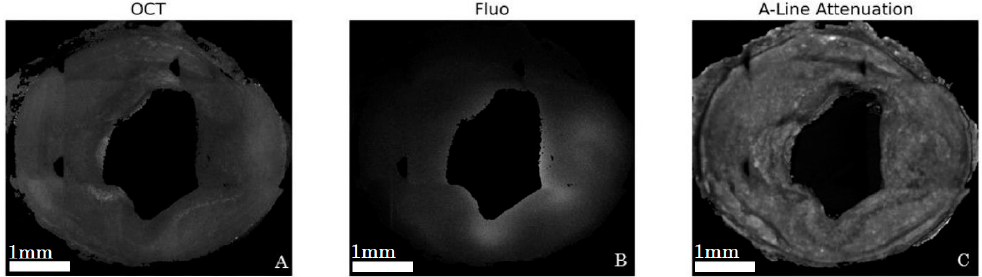
Figure 4. Corrected images for model 1 rabbit for OCT ( A ); and fluorescence ( B ); A-line attenuation map used for OCT intensity correction outlines detailed tissue structures ( C ). map used for OCT intensity correction outlines detailed tissue structures ( C